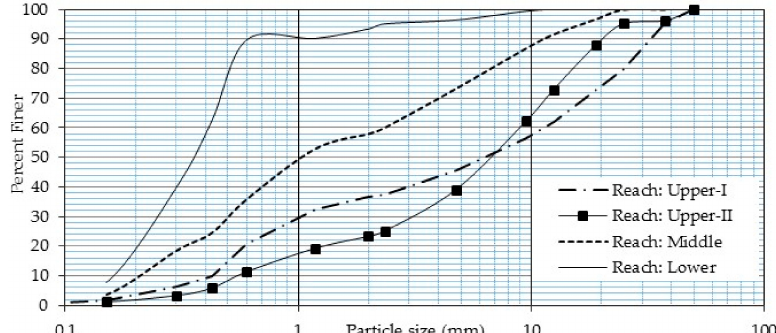
Figure 7. Grain size distribution of Ribb River bed material downstream of the Ribb Dam site, upstream and downstream of the weir site and upstream of the Ribb Bridge, at Universal Transverse Mercator (UTM) coordinates 37P 0388475, 1332080, 1872 m a.s.l.; 37P 0373692, 1329576, 1819 m a.s.l.; 37P 0368803, 1330762, 1804 m a.s.l. and 37P 0359808, 1326196, 1795 m a.s.l., respectively (Samples were collected in March